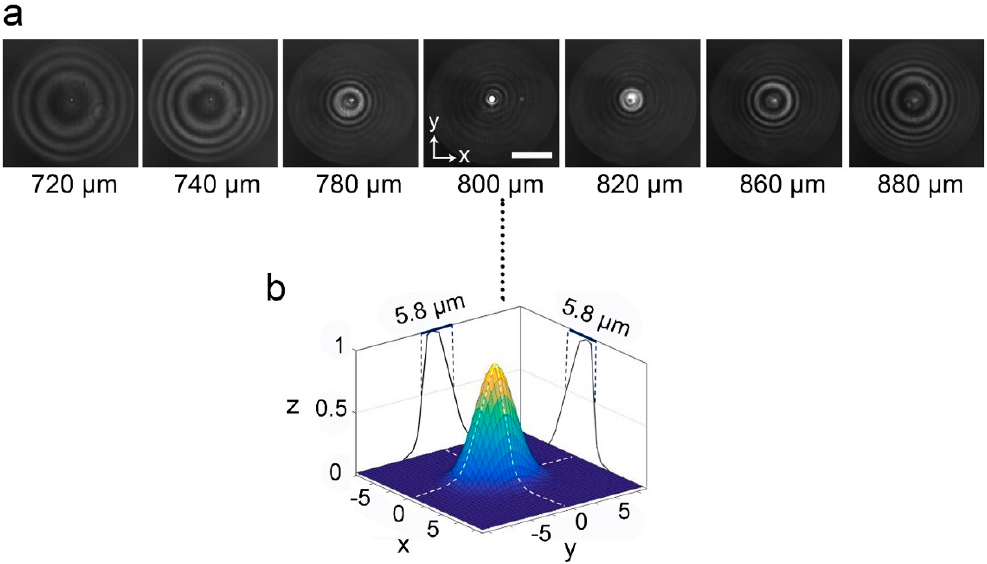
Figure 4. ( a ) The measurement of the intensity distribution at different locations from the metalens surface for 1064 nm laser light with 30 mW power. The scale bar is 50 µm. The laser beam was focused sharply at 800 μ m corresponding to the design. ( b ) The interpolated surface plot from the intensity measurement at 800 μ m gives a full width at half maximum (FWHM) spot size of 5.8 µm.